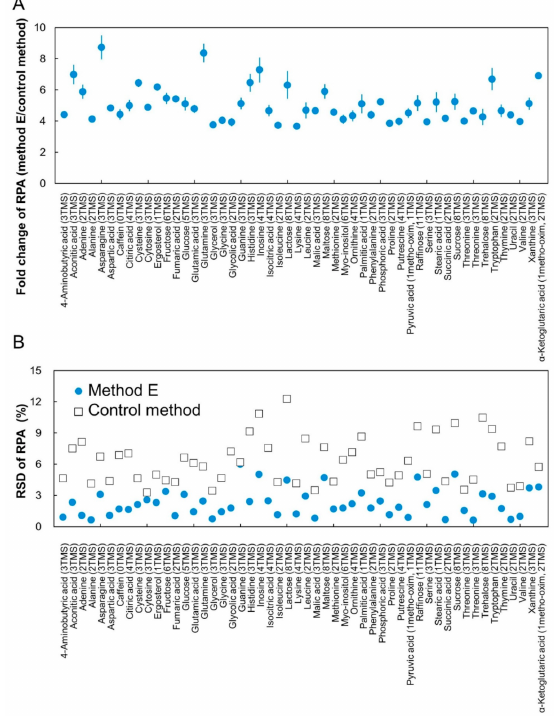
Figure 3. Improvement in sensitivity by the optimization of derivatization reaction. Each RPA with method E was dividing by that with control method, which was defined as the fold change of RPA ( A ). Repeatability of RPA for each metabolite is shown in ( B ). Error bars represent the standard deviation ( n =